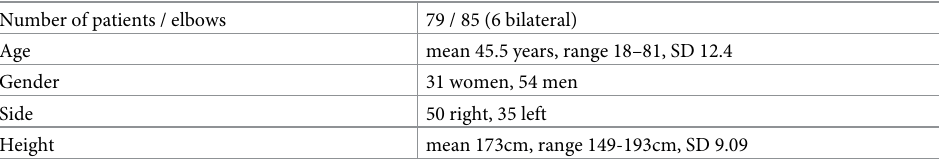
Inclusion criteria was an available MRI scan (1.5 Tesla) with visible distal biceps tendon (from the distal myotendinous junction to radial tuberosity) on axial images, conventional calibrated radiographs (A/P), age of � 18 years and measured body height. Excluded were all patients with a pathology of the distal biceps tendon (tendinopathy / tear visible on MRI, pain on palpa- tion of distal biceps tendon), surgery of the biceps brachii muscle (proximal or distal), exten- sion/flexion contractions of the elbow and malunion/osteoarthritic changes of the radial head and epicondyles. All MRI scans were performed in superman position (prone position with the arm extended over the head). Ethical approval was granted by Kantonale Ethikkommission of Zurich, Switzerland (BASEC-Nr. 2019–00286), and informed written consent was obtained from all individual participants included in the